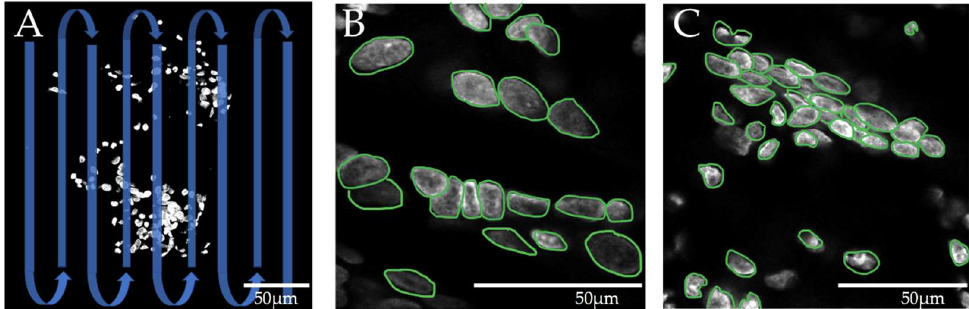
Figure 3. Representation of the manual counting of cell nuclei. Nuclei borders are marked with green outlines. ( A ) Meandering scanning of the confocal image. ( B ) Area with contact points of some nuclei (good delimit ability). ( C ) Cell nuclei aggregate with increasingly difficult differentiability of individual nuclei boundaries.